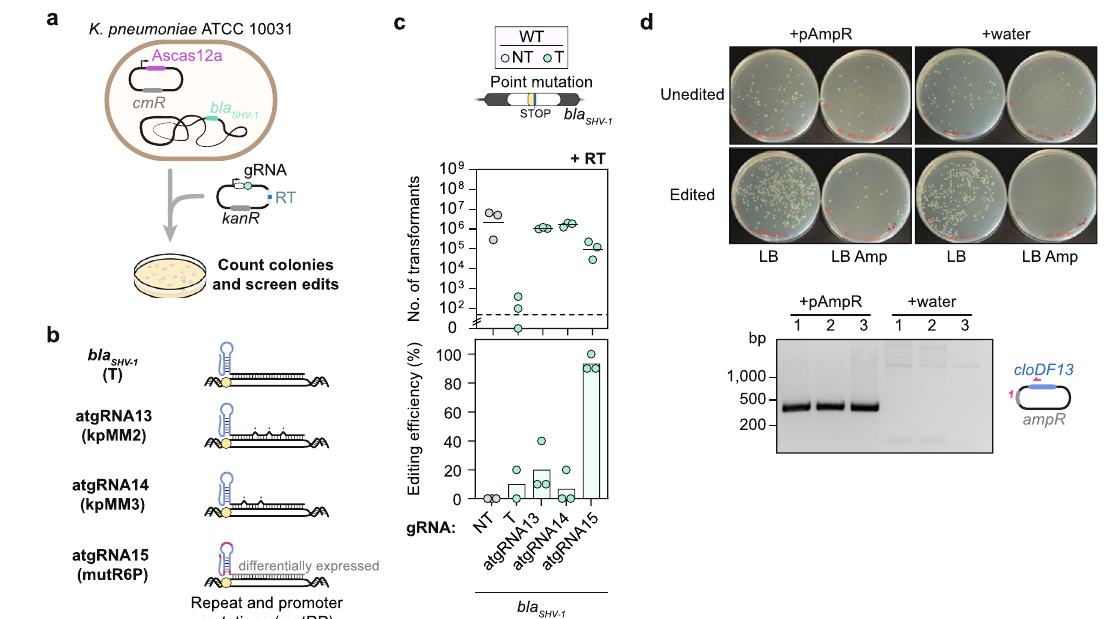
Fig. 5 | Attenuated gRNAs can be applied to reverse antibiotic resistance in multidrug-resistant Klebsiella pneumoniae. a Schematic of genome editing assay. b Schematic of canonical and attenuated guide design. c Genome editing assay in K. pneumoniae to introduce a stop codon in the bla SHV-1 gene. Each dot in theeditingplotistheresultobtainedafterscreening10and3coloniesrespectively forthe Tand NT samples. Barsindicate the meanofthedots.Forthe TgRNA, each dot represents the editing ef fi ciency obtained for 4 colonies due to the absence of othercoloniesontheplates.Oneofthebiologicalreplicatesyieldednocoloniesfor thiscondition.Thedashedlineindicatesthelimit-of-detection.SeeFig.1fordetails. The mean number of transformants (indicated by a horizontal line) was not cal- culatedfor samples with biologicalreplicatesthat fellbelow the limit-of-detection.